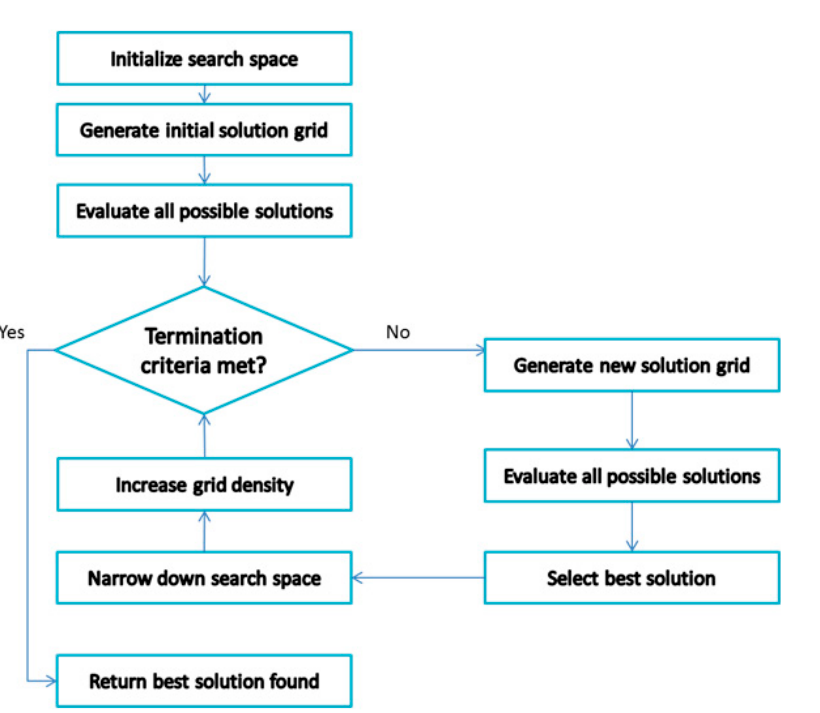
Figure 9. Flow chart of Hybrid Grid Luus–Jaakola method.